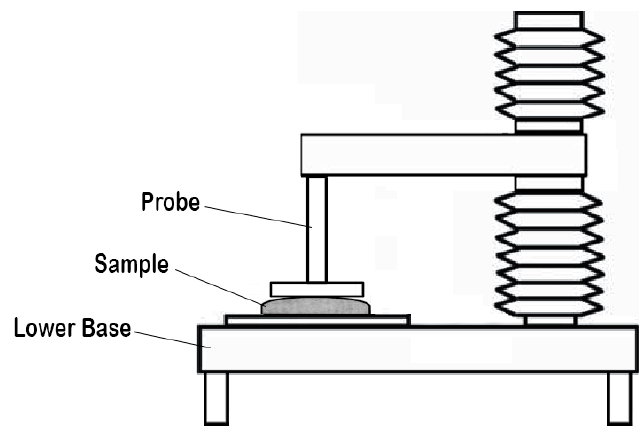
Figure 1. Schematic diagram of the texture analyzer.